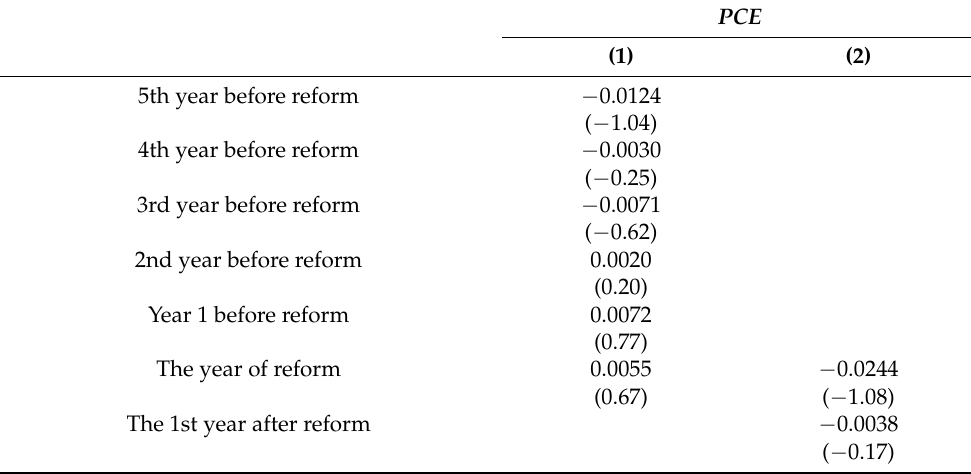
Table 5. Placebo test of